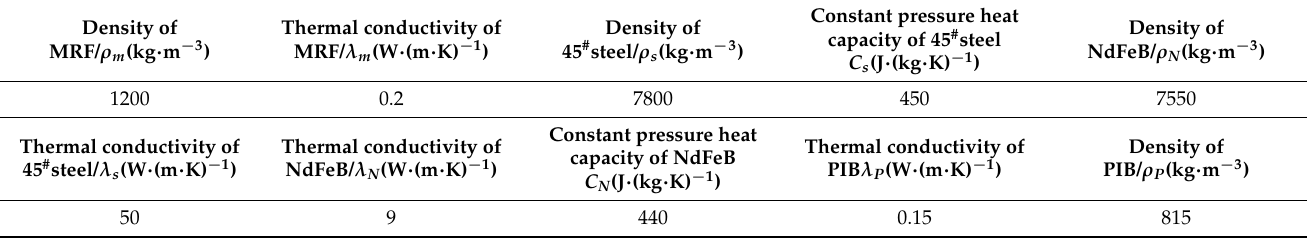
Table 2. Thermodynamic Parameters of Various Materials in Temperature Field Simulation.